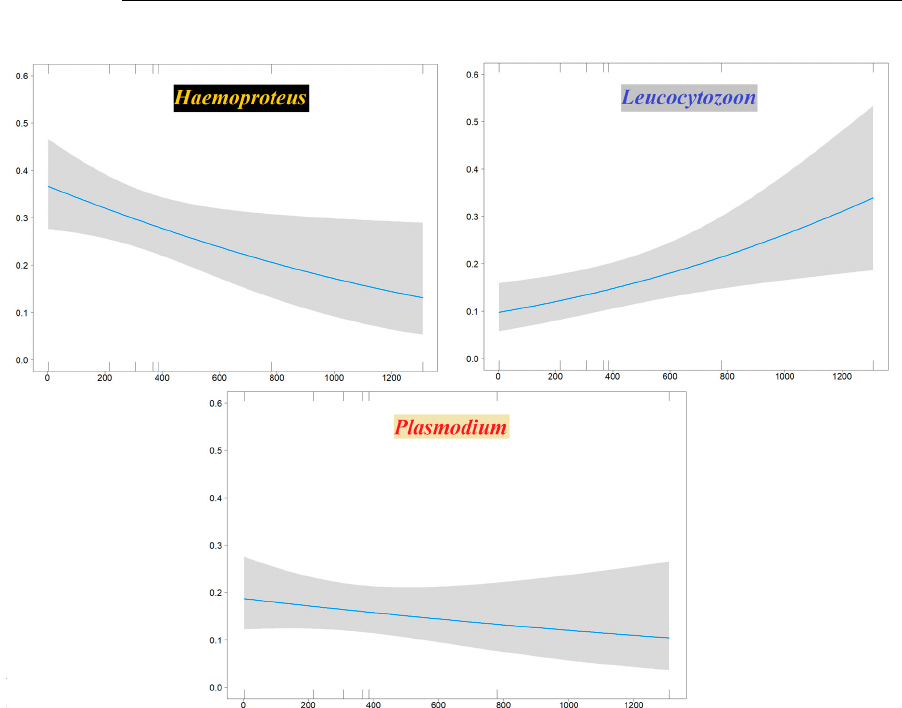
Figure 4. Plots showing the effects of the sampling site elevation ( X axis: meters asl) on the occurrence probability ( Y axis) of Haemoproteus (left), Leucocytozoon (right), Plasmodium (bottom) on Sardinian